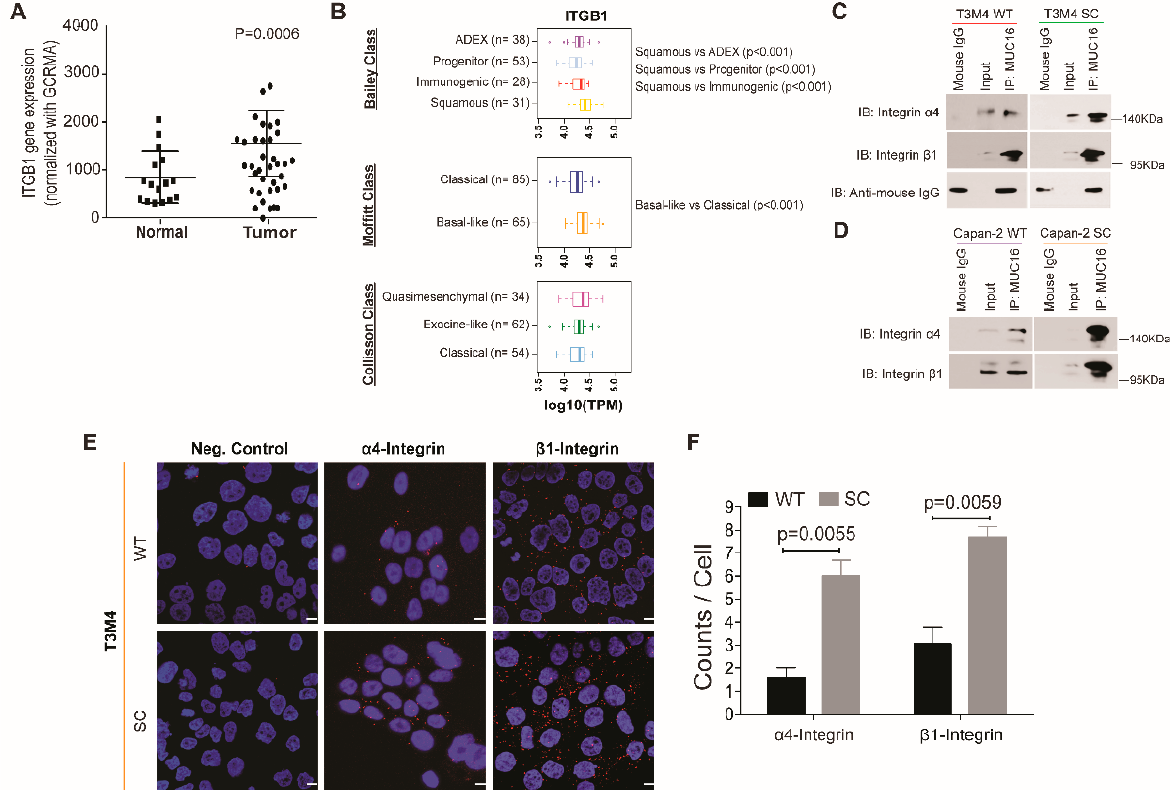
Figure 3. Truncated O-glycan-containing MUC16 interacts with α 4 β 1 integrins. ( A ) mRNA expres- sion of the ITGB1 gene (encoding Integrin β 1) was determined using microarray data from normal ( n = 16) and PDAC tumor ( n = 36) tissues; p value < 0.05 is considered statistically significant; ( B ) box plots showing ITGB1 expression level stratified by mRNA expression data from Bailey class, Moffitt class, and Collisson class of PDAC; box plots were generated by comparing the expression of the ITGB1 gene among the subtypes indicated by using the Mann–Whitney rank-sum test; p value < 0.01 is considered statistically significant; immunoprecipitation analysis in ( C ) T3M4 WT and SC cells and ( D ) Capan-2 WT and SC cells show an association of MUC16 with integrin α 4 and integrin β 1 (IP: immunoprecipitation, IB: immunoblot); ( E ) proximity ligation assay (PLA) using antibodies for MUC16, integrin α 4, and integrin β 1 in T3M4 WT and SC cells; scale bar is equivalent to 10 µ m. ( F ) quantification of the interaction as counts per cell using the blob finder 2 software; negative control: incubation of cells with antibodies against a single antigen; data presented as mean ± SEM and analyzed using the unpaired t test ( n = 3); p < 0.05 is considered statistically significant.